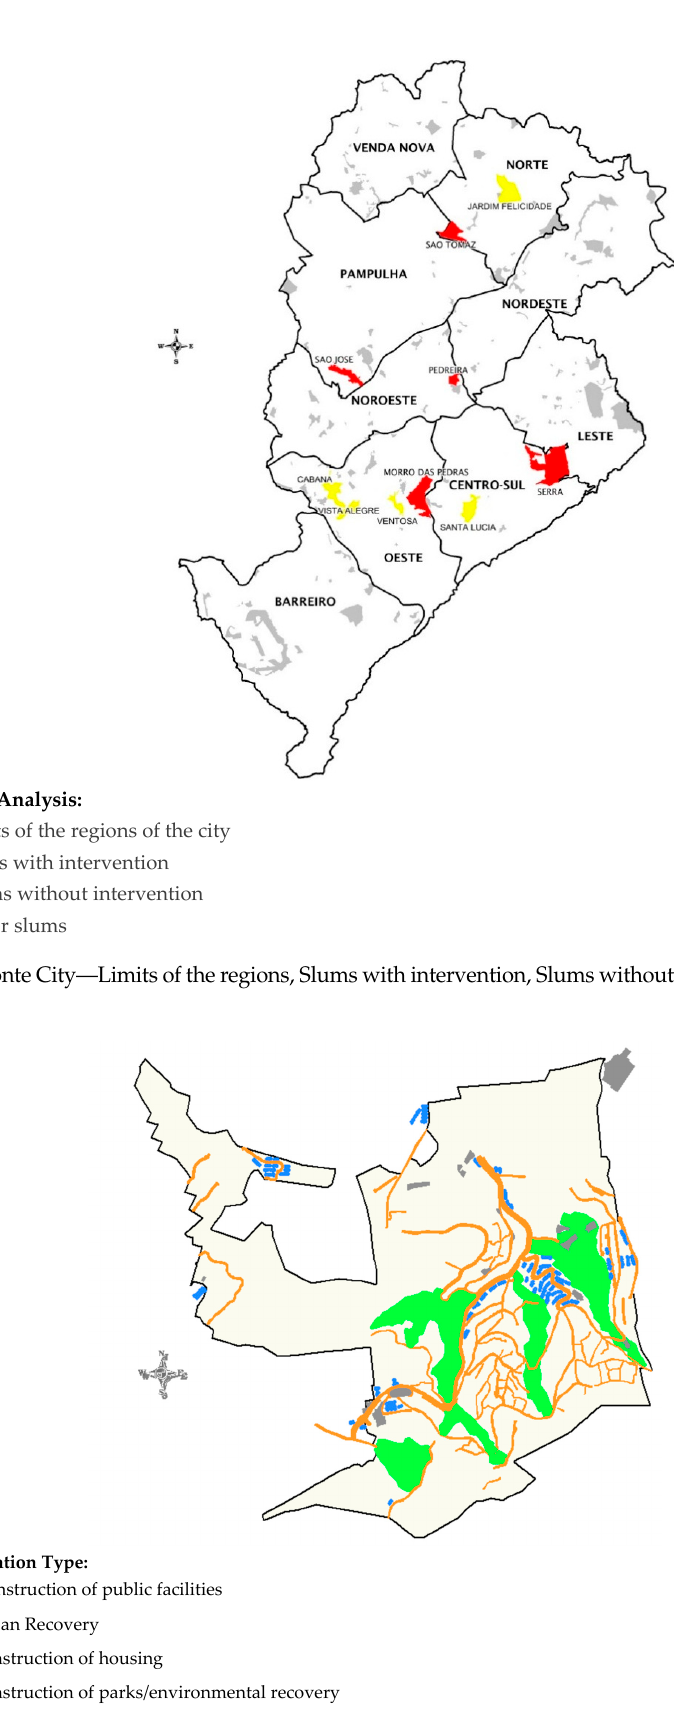
Figure 2. Vila Viva Project’s interventions by type of interventions—Vila S1